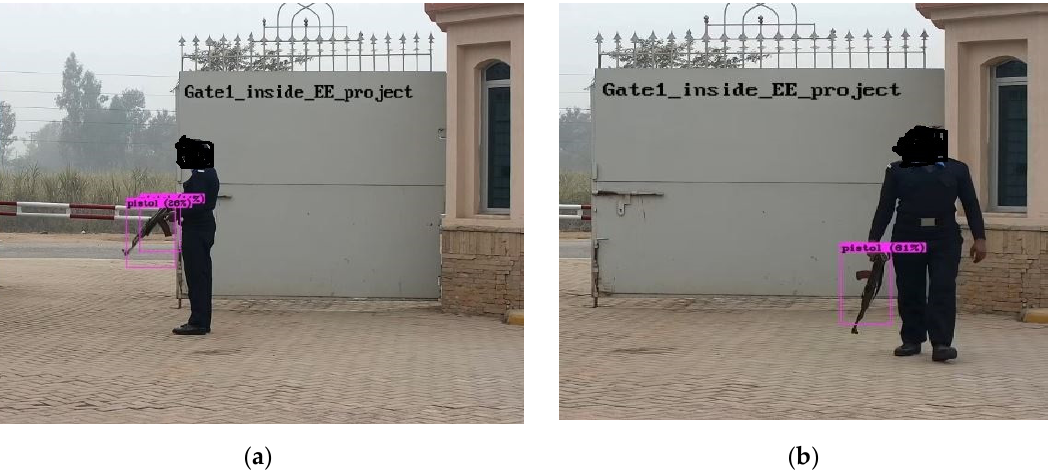
Figure 18. Detection results of Scaled-YOLOv4 in real-time CCTV stream. ( a ) Image with a rifle as weapon held diagonally. ( b ) Image with a rifle as a weapon held upside down slightly tilted.